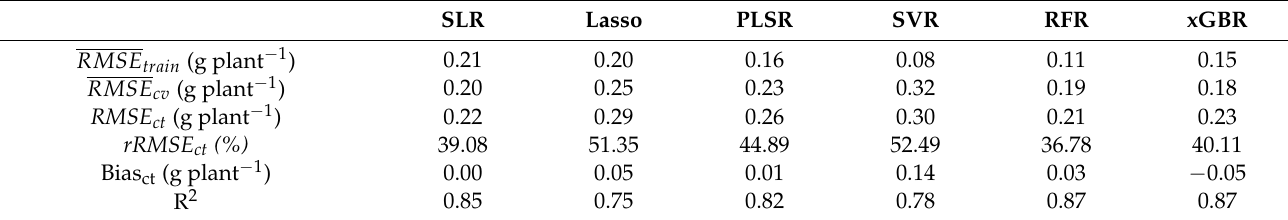
Table 4. Summary of the model performance based on RMSE train across all LOF-CV iterations, the RMSE cv , Bias ct , and R 2 for N-uptake (gN plant − 1 ). The SLR model performance is based on the median RWDRVI model.